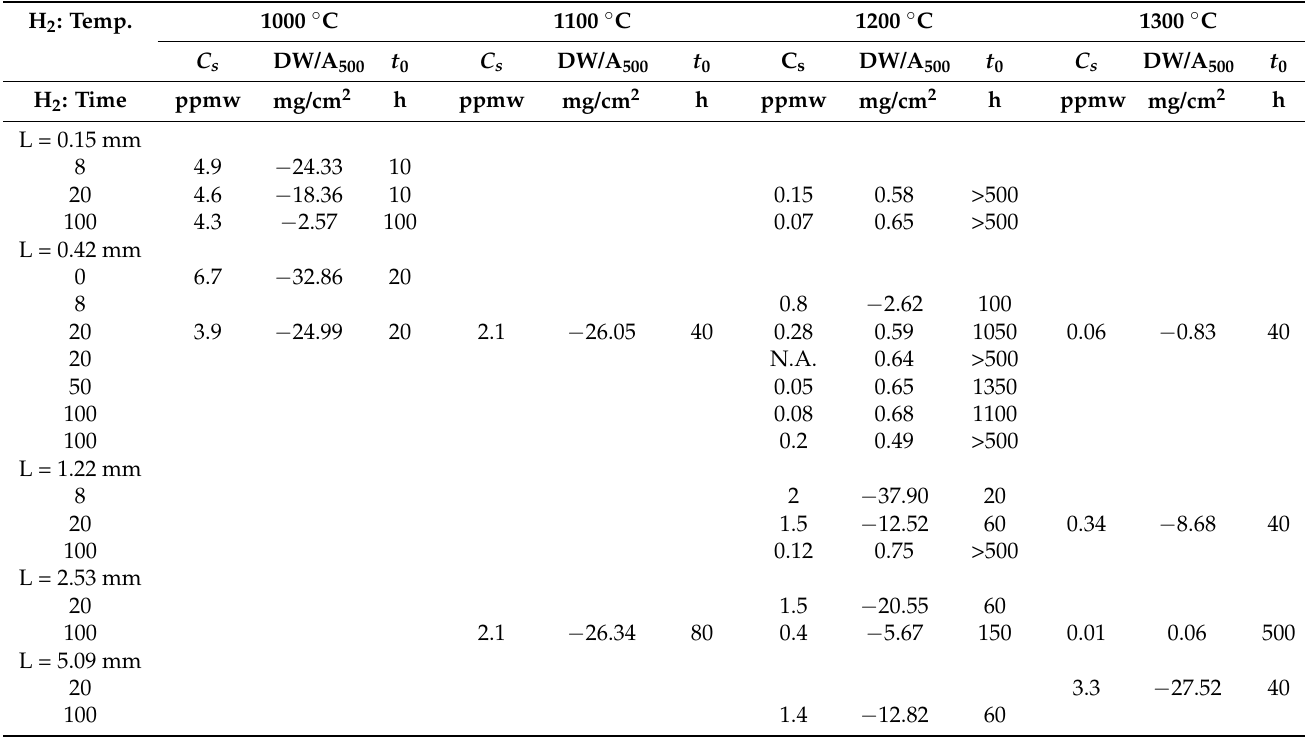
Table 5. Correlation of cyclic oxidation behavior figures of merit with sulfur content ( C S ) and sample thickness (L). PWA 1480, 500 h weight change ( ∆ W/A 500 ) and time to cross zero weight ( t 0 ). Sulfur content was initially reduced by annealing at 1000–1300 ◦ C for 8–100 h in 5% H 2